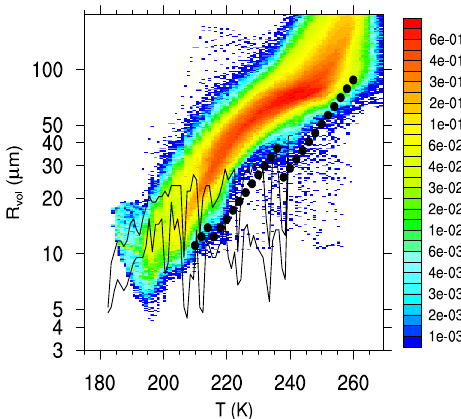
Figure 14. Global frequency of ice volumetric radius as a function of temperature from GEOS-5, NEW run. Solid lines represent the 25 and 75% quantiles from the field campaign analysis of Krämer et al. (2009). Filled circles were calculated using the correlation ob- tained by McFarquhar and Heymsfield (1997) from field measure- ments in mixed-phase and cirrus